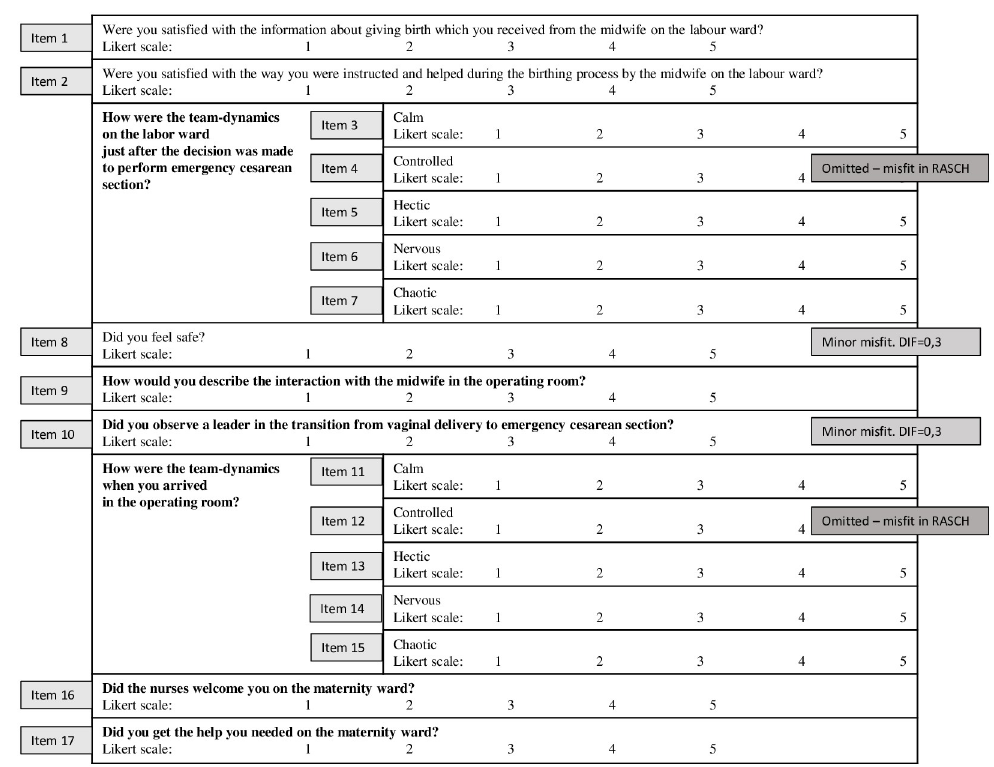
Fig 2. Maternal questionnaire. Likert scale is a visual analog scale that measure subjective characteristics. The Likert items state the level of disagreement = 1; agreement = 5. Misfit: Rasch analysis is a statistical methodology that tests if the observed item scores are consistent with measurement requirements. If this is not the case, there is a misfit. If the misfit is high the questionnaire item is omitted (left